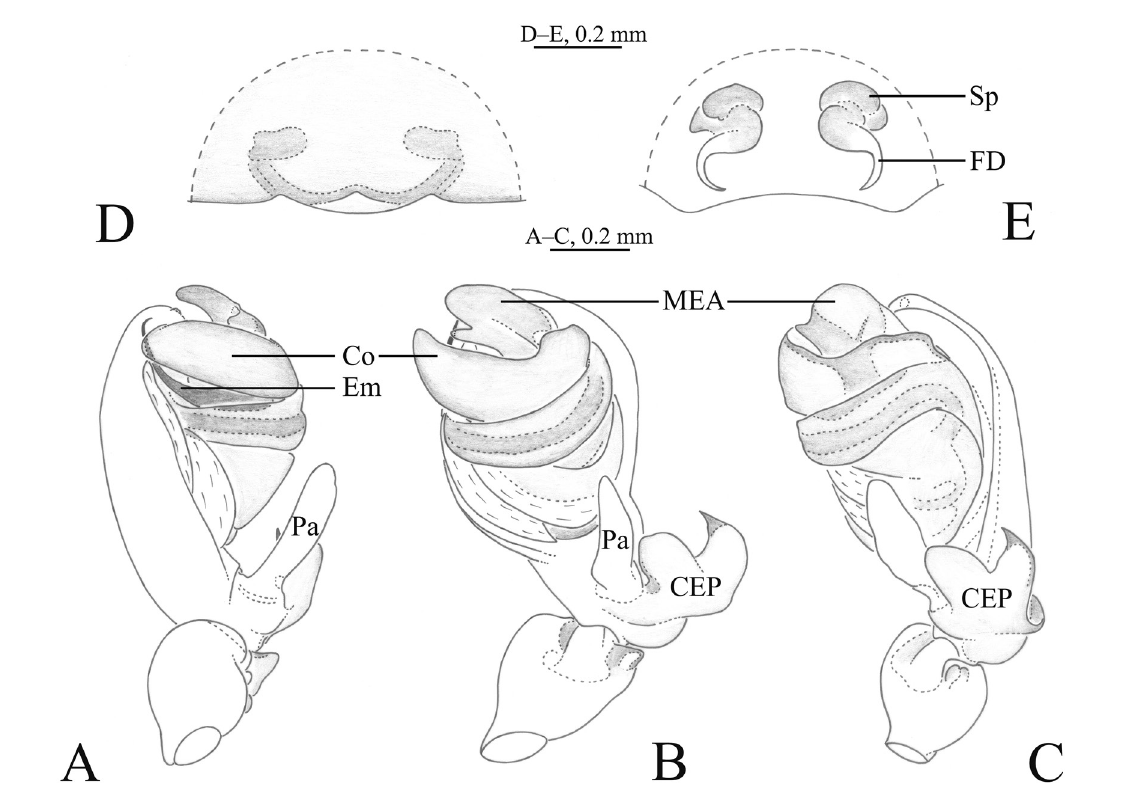
Fig. 10. Meta hongyuan sp. nov. A–C . ♂, holotype (SWUC-T-TEg-05-01). D–E . ♀, paratype (SWUC-T- TEg-05-03). A . Left palp, prolateral view. B . Same, ventral view. C . Same, retrolateral view. D . Epigyne, ventral view. E . Vulva, dorsal